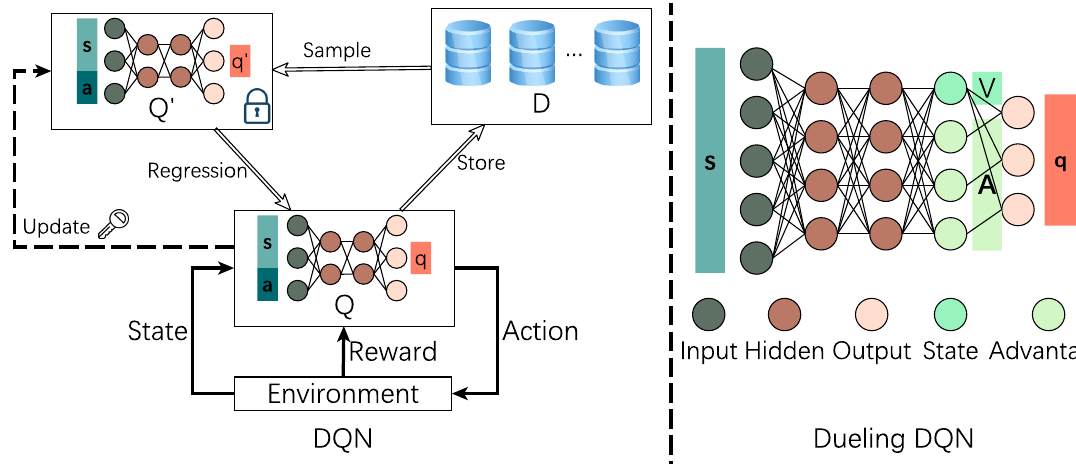
Figure 5. Deep Q Networks (DQN) and Dueling